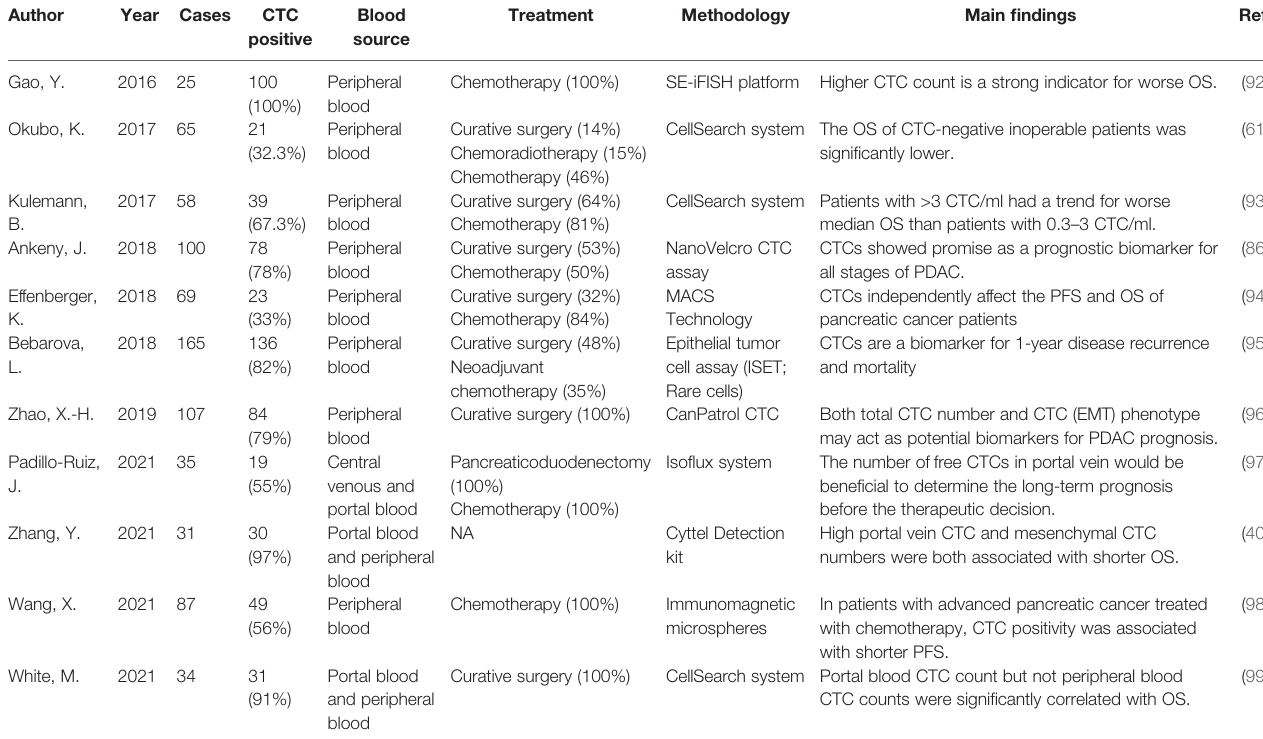
TABLE 3 | Studies evaluating the prognostic value of CTCs in